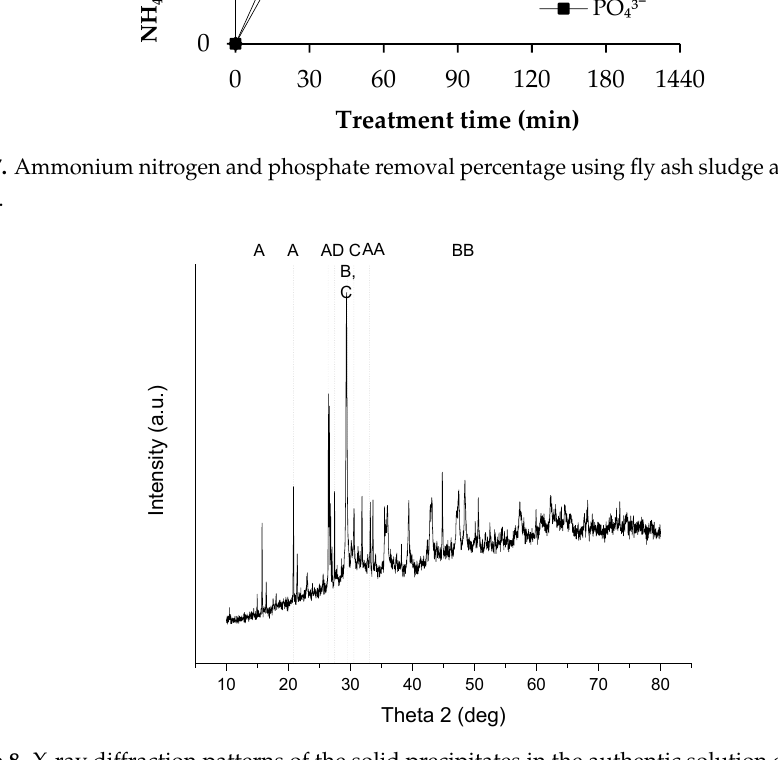
Figure 8. X-ray diffraction patterns of the solid precipitates in the authentic solution experiments.